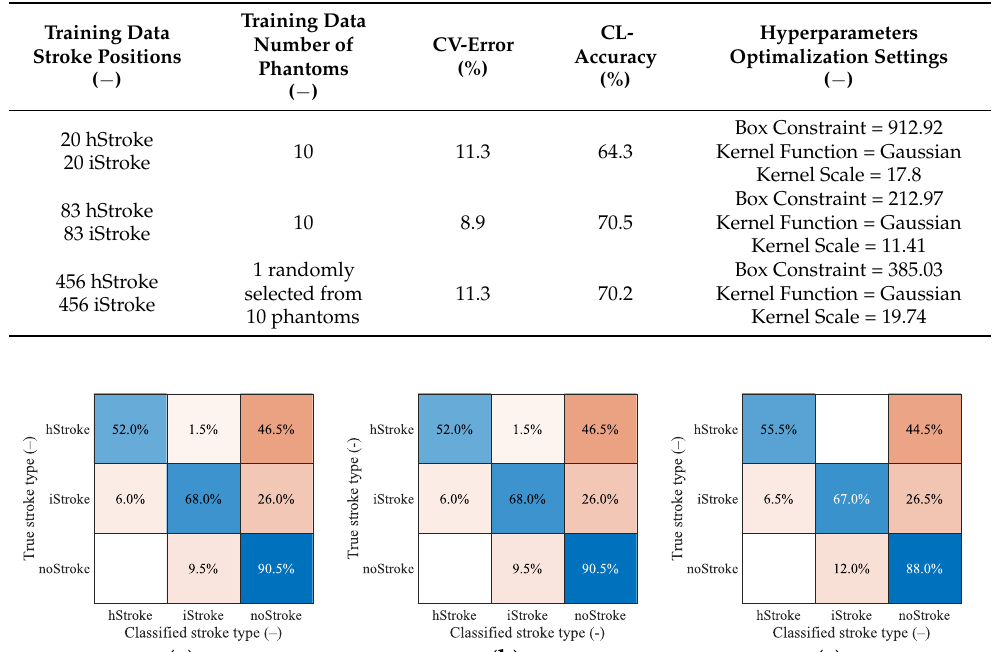
Table 9. The SVM algorithm classification of random stroke sizes and random stroke positions with different amounts of training data (different number of 20 mm stroke positions in the head).